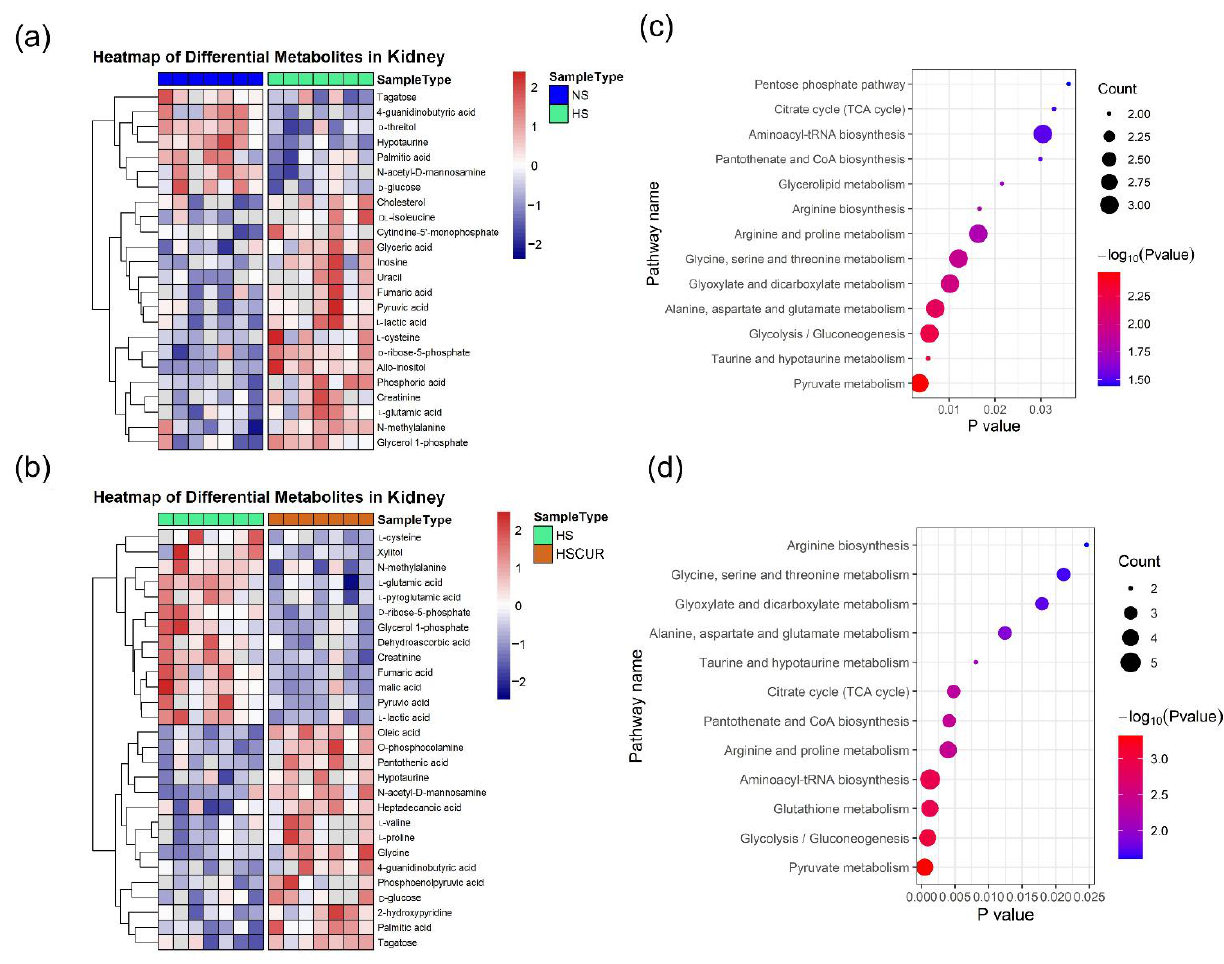
Figure 7. Statistical analysis of renal metabolomics dataset. Heatmap clustering analysis of differential metabolites between the NS and HS groups ( a ), the HS and HSCUR groups ( b ); pathway enrichment analysis based on differential metabolites between the NS and HS groups ( c ), the HS and HSCUR groups ( d ). The differential metabolites was identified according to Mann – Whitney – Wilcoxon test with the false discovery rate (FDR) adjusted p -value (<0.05).